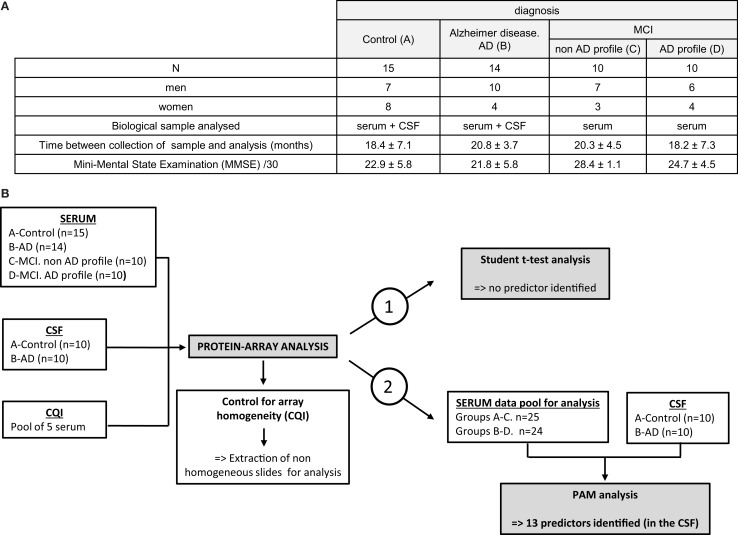
Cohort patients and study outline. (A) A total of 49 patients were included in the preliminary study for protein-arrays analysis: 15 control subjects (A), 14 AD late-stage patients (B) and 20 MCI (mild cognitive impairment): 10 MCI with non-AD profile (C) and 10 MCI presenting AD profile (D). Serum was analyzed for every patient included; CSF was analyzed for 20 of them (10 patients from groups A and B). Time between collection of samples (serum and CSF) and their analysis is indicated (in months): results are mean ± SD. Mini-mental state examination (MMSE) is indicated (MMSE/30) as mean ± SD. (B) Sera, CSF, and our internal quality control (CQI, corresponding to a pool of five control sera) were hybridized on the protein arrays. Homogeneity of the slides was controlled thanks to the CQI: non-homogeneous slide identified was extracted before proceeding to the analysis of the arrays. Normalized array data of 120 serum signaling proteins were analyzed in the training set with statistical Student’s t-test to discover differences in protein abundance between samples (strategy 1). As no predictor could be identified, serum data were pooled for groups A–C and B–D (strategy 2). To discover predictors for classification, the training set was analyzed through prediction analysis for microarrays (PAM) approach.